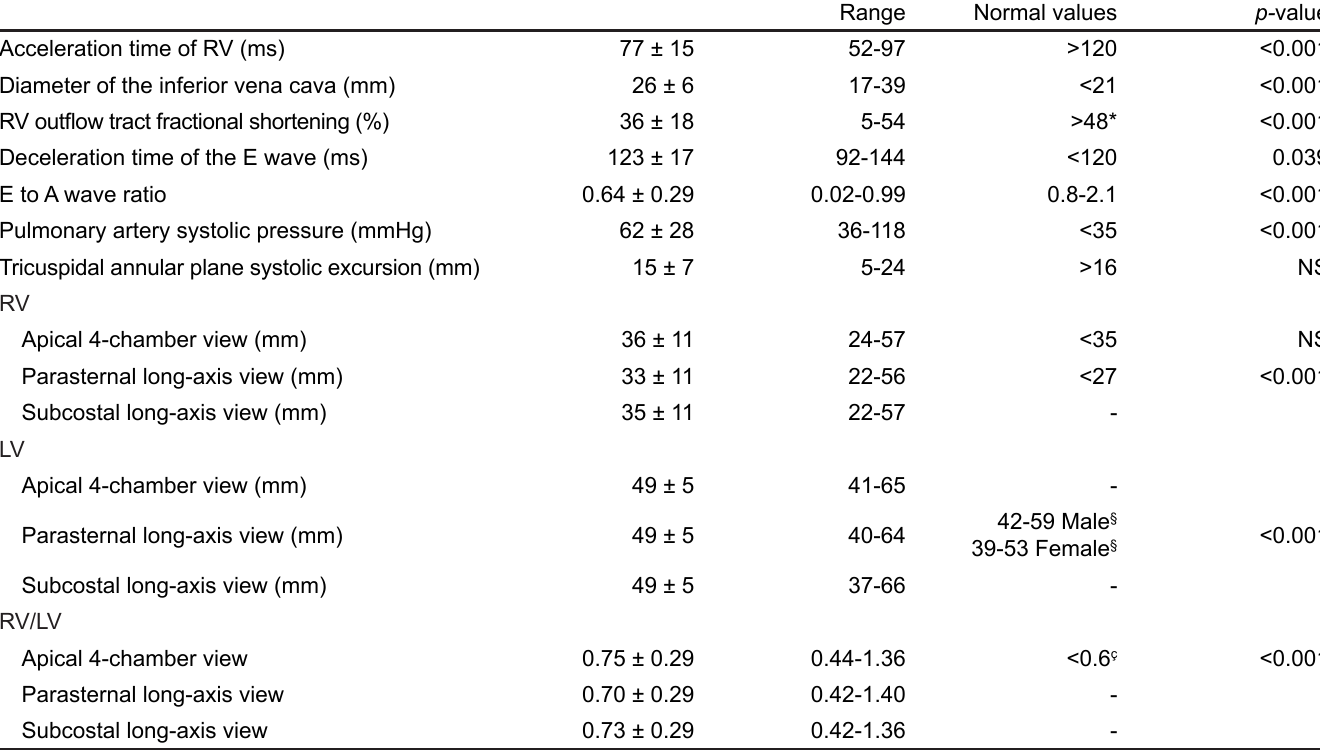
Table 1. Echocardiographic indices upon presentation to emergency